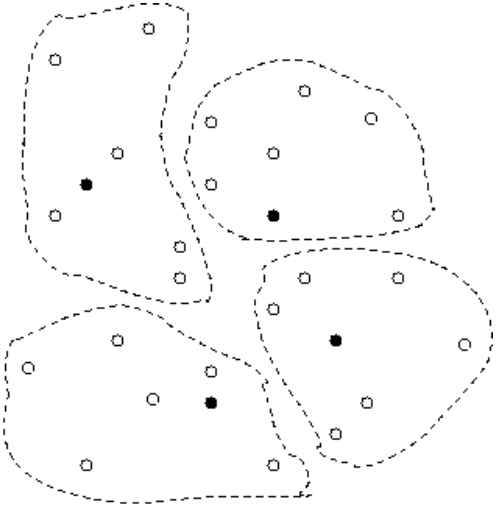
Figure 7. The output of the algorithm on a sample network. Each master node can handle 6 sensors.